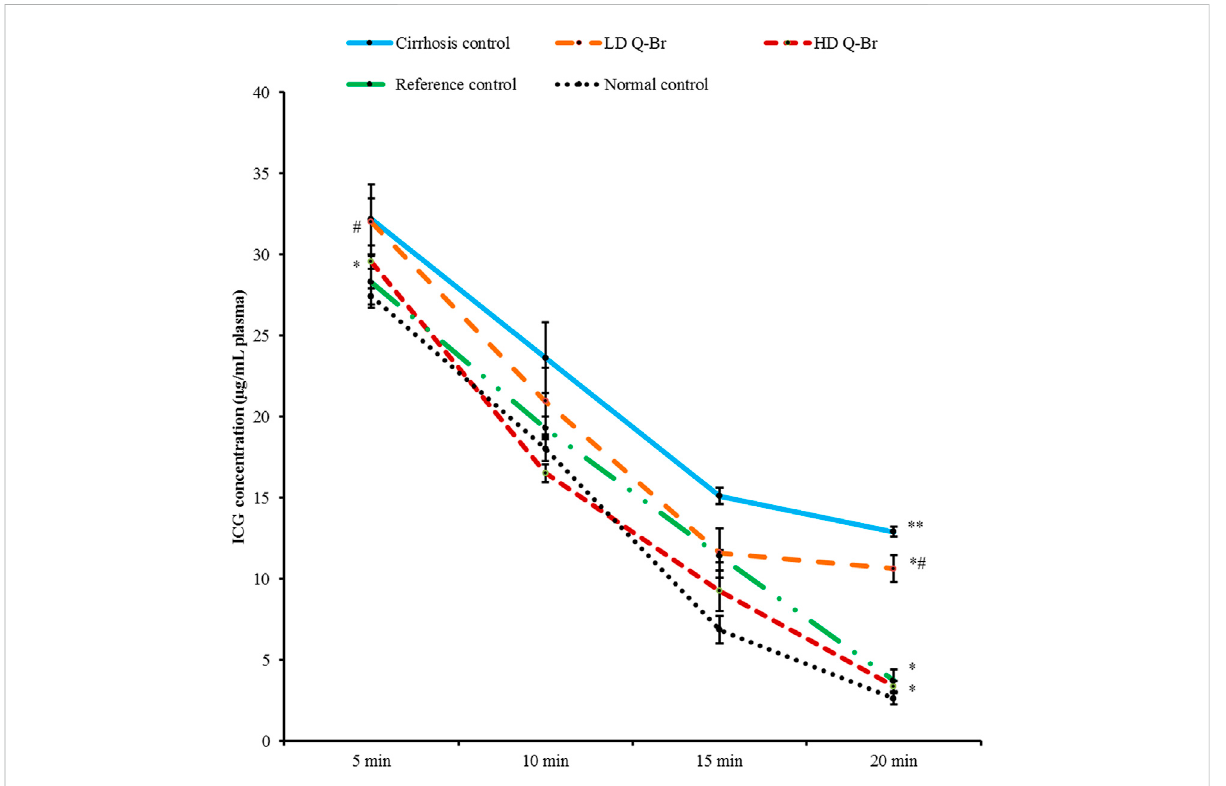
FIGURE 3 Plasma ICG concentration measured from all experimental groups at 5, 10, 15, and 20 min post intravenous injection of ICG bolus (0.5 mg/kg) into the tail vein. Cirrhosis control: TAA-treated rats; the LD Q-Br treated group (25 mg/kg); the HD Q-Br treated group (50 mg/kg). Silymarin- treated rats (50 mg/kg); Normal: the liver from normal rat given 5% Tween 20. Data are displayed as mean ± SD ( n = 3) and p < 0.05 was considered signi fi cantly considered. ** p < 0.05 vs. normal (healthy) group and * p < 0.05 vs. cirrhosis control group.